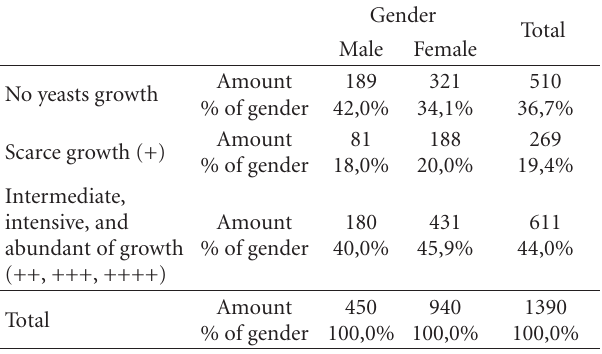
Table 9: Distribution of yeasts growth according to gender.